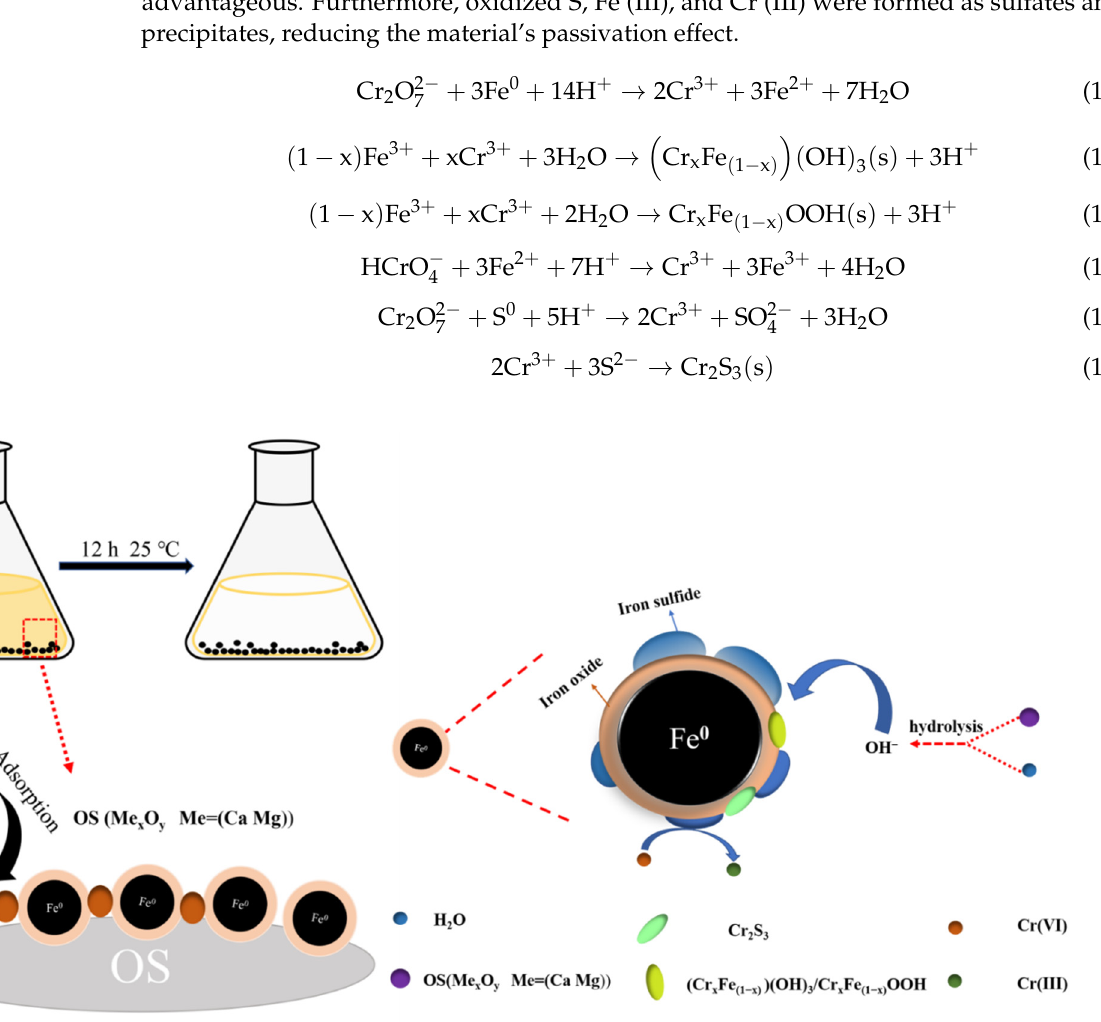
Figure 10. Schematic representation for mechanistic pathway of Cr (VI) reduction by S-nZVI@OS.